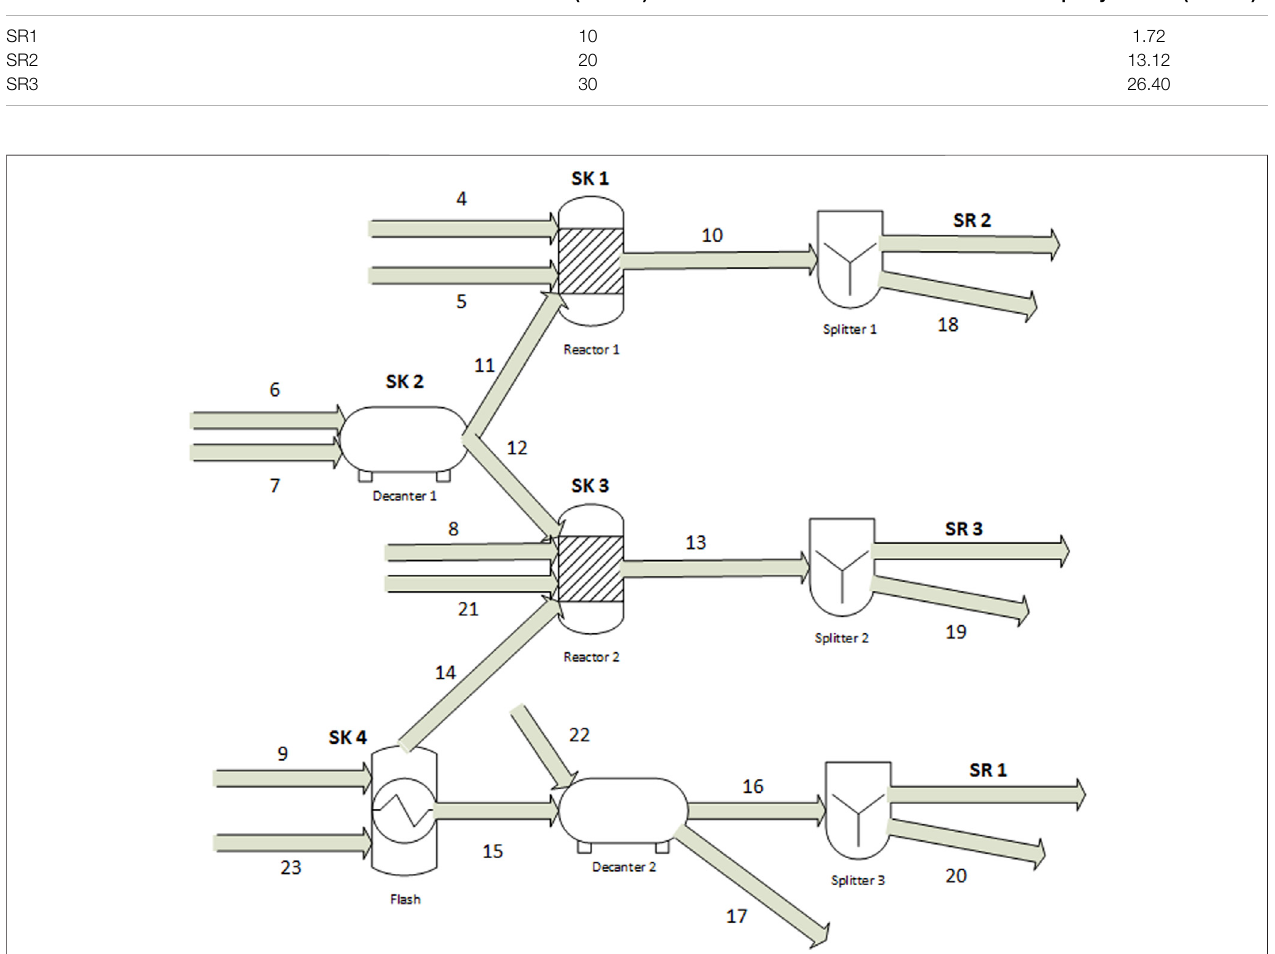
FIGURE 7 | Process fl owsheet for the case study-2 highlighting all process sinks and sources.